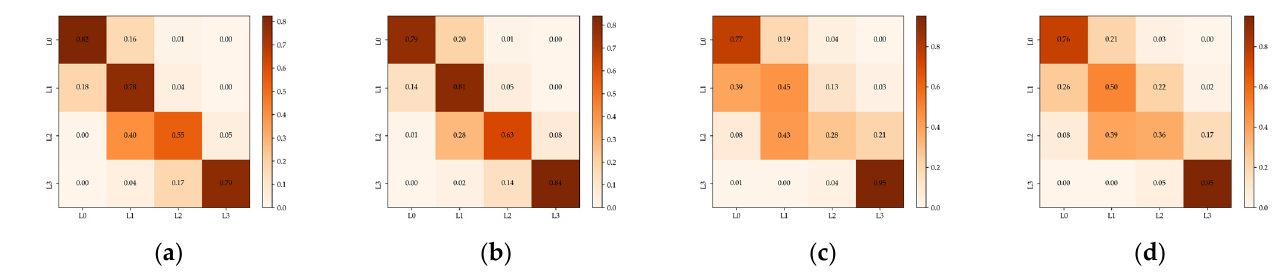
The bold font indicates the best accuracy of each indicator.